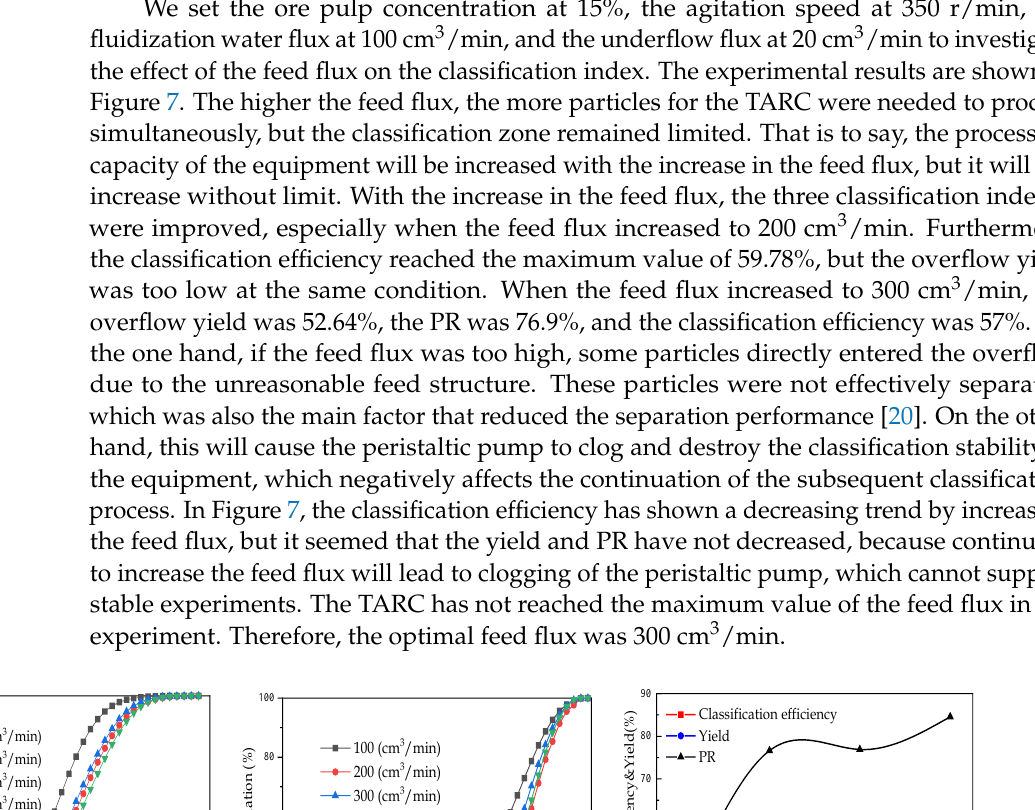
( c ) Figure 8. ( a ) Overflow particle size; ( b ) underflow particle size; ( c ) classification index. Experiment on the effect of underflow flux condition. 4.5. Fluidization Water Flux Results We set the ore pulp concentration at 15%, the agitation speed at 350 r/min, the feed flux at 300 cm 3 /min, and the underflow flux at 16 cm 3 /min to investigate the influence of the fluidization water flux on the classification index. The fluidization water not only ensured that the particles were in a better dispersion state, but it was also used for the leaching of ultrafine particles in the fluidized bed [5]. An excessively high rising water flow will inevitably bring particles with a size greater than 10 µm into the overflow products; thus, it is important to determine the value of the fluidization water. The